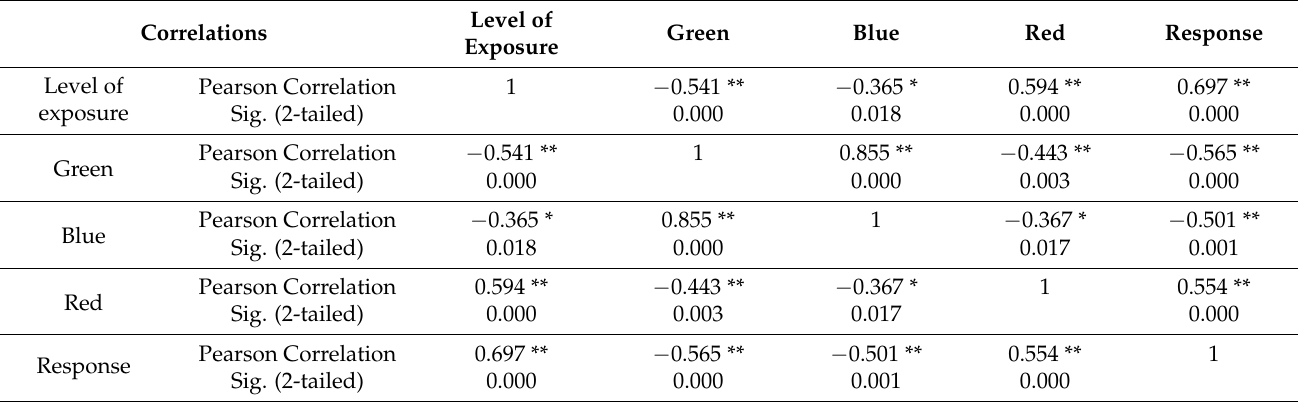
Table 4. The correlation between the collected perceptual response as a dependent variable and the level of pollution and the RGB values as independent